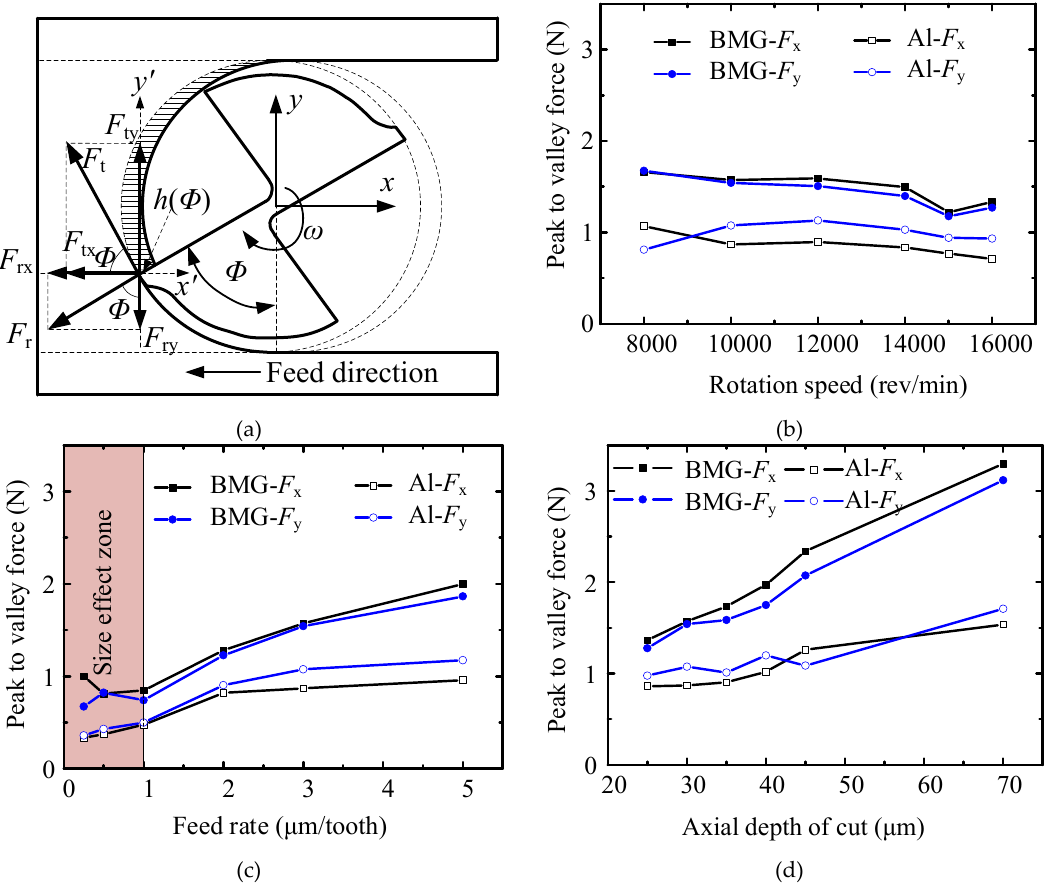
Figure 14. The influence of milling parameters on milling force. ( a ) The schematic diagram of the milling process; ( b ) the influence of rotation speed; ( c ) the influence of feed rate; ( d ) the influence of axial depth of cut.